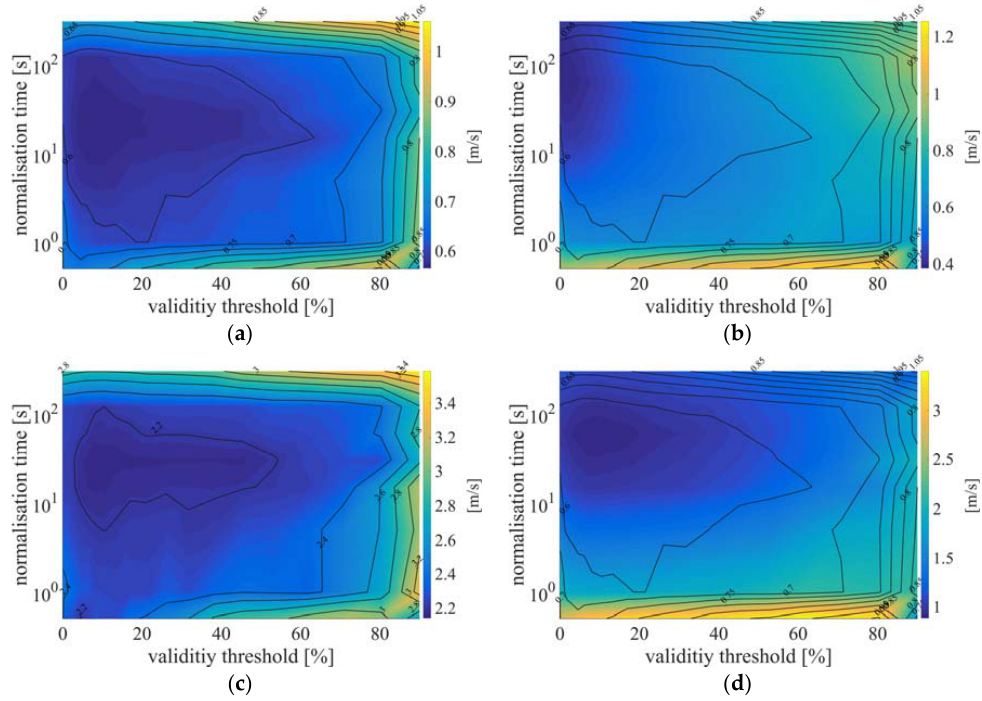
Figure A1. Visualisation of the influence of the normalisation time ∆(cid:1872) and validity value (cid:2021) on the resulting total error. Staring mode LiDAR data from 21.12.2013 15:35h (UTC) till 19.01.2014 7:55h (UTC) form the basis for this calculation. ( a ) Average velocity error, ( b ) the average velocity standard deviation error, ( c ) RMS velocity error and ( d ) RMS velocity standard deviation error.